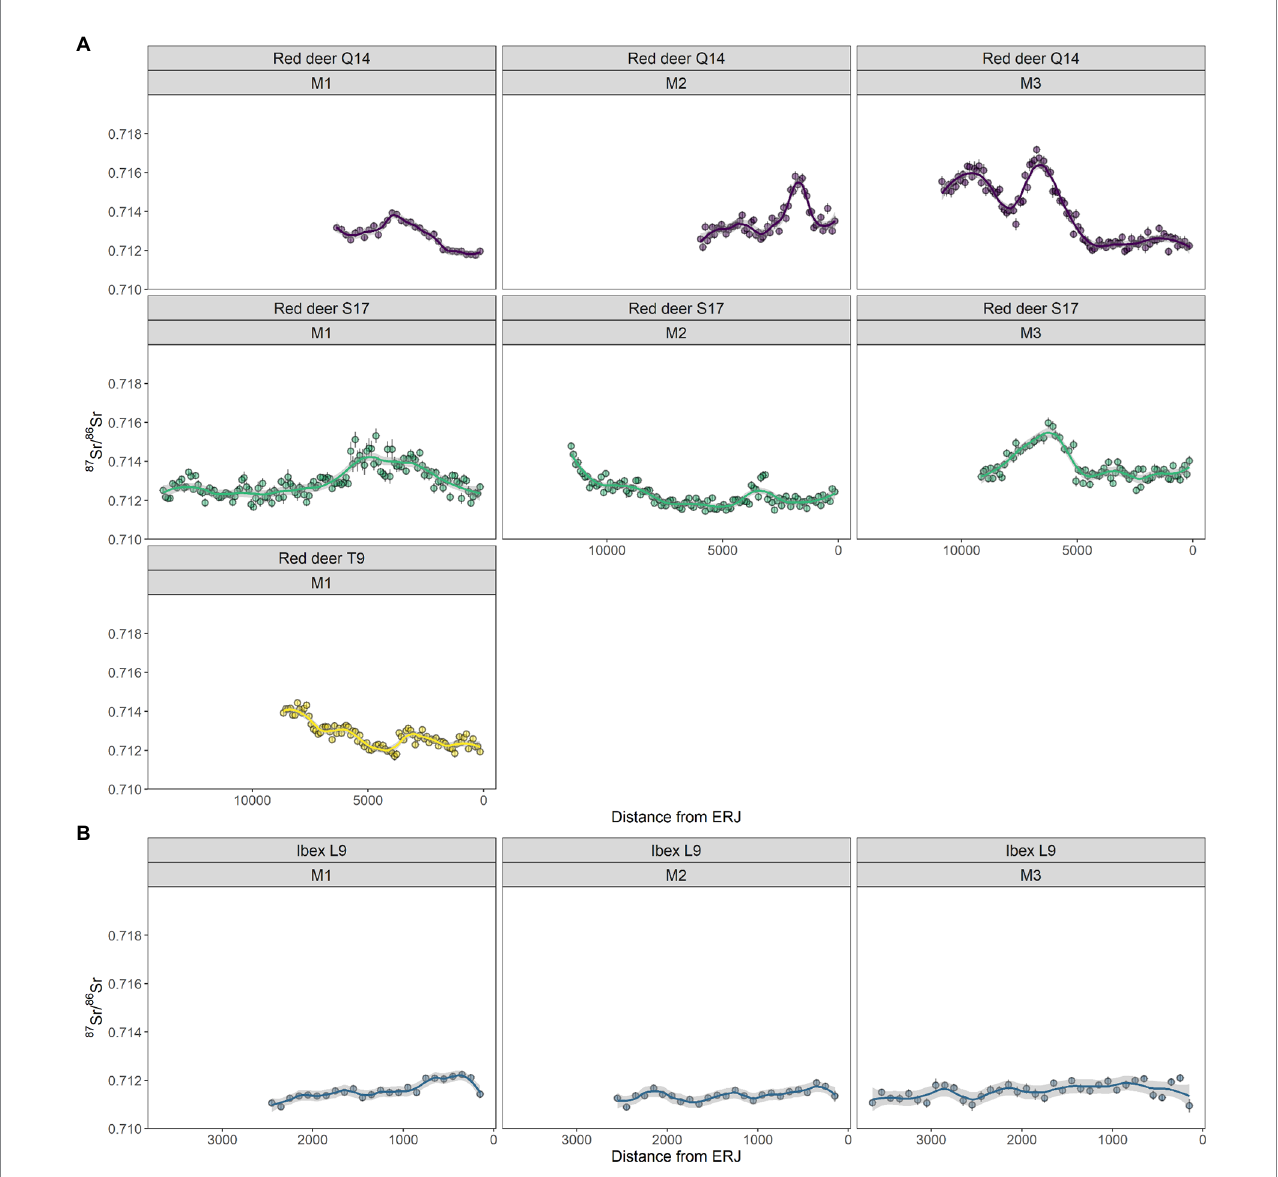
FIGURE 6 87 Sr/ 86 Sr LA-MC-ICP-MS results for three red deer (shown in A ) and an ibex (shown in B ). Each fauna is represented by a different colour and displayed in rows. Columns represent different teeth (from left to right first, second and third molar). The x-axis represents the laser ablation distance from the ERJ. Graphs are read from left to right with the oldest section of tooth (crown) on the far left and the latest-forming portion of the tooth (enamel-root junction) located on the right-hand side of the graph. Individual dots represent a single 100 μ m spot while the line follows the trend of the laser ablation data